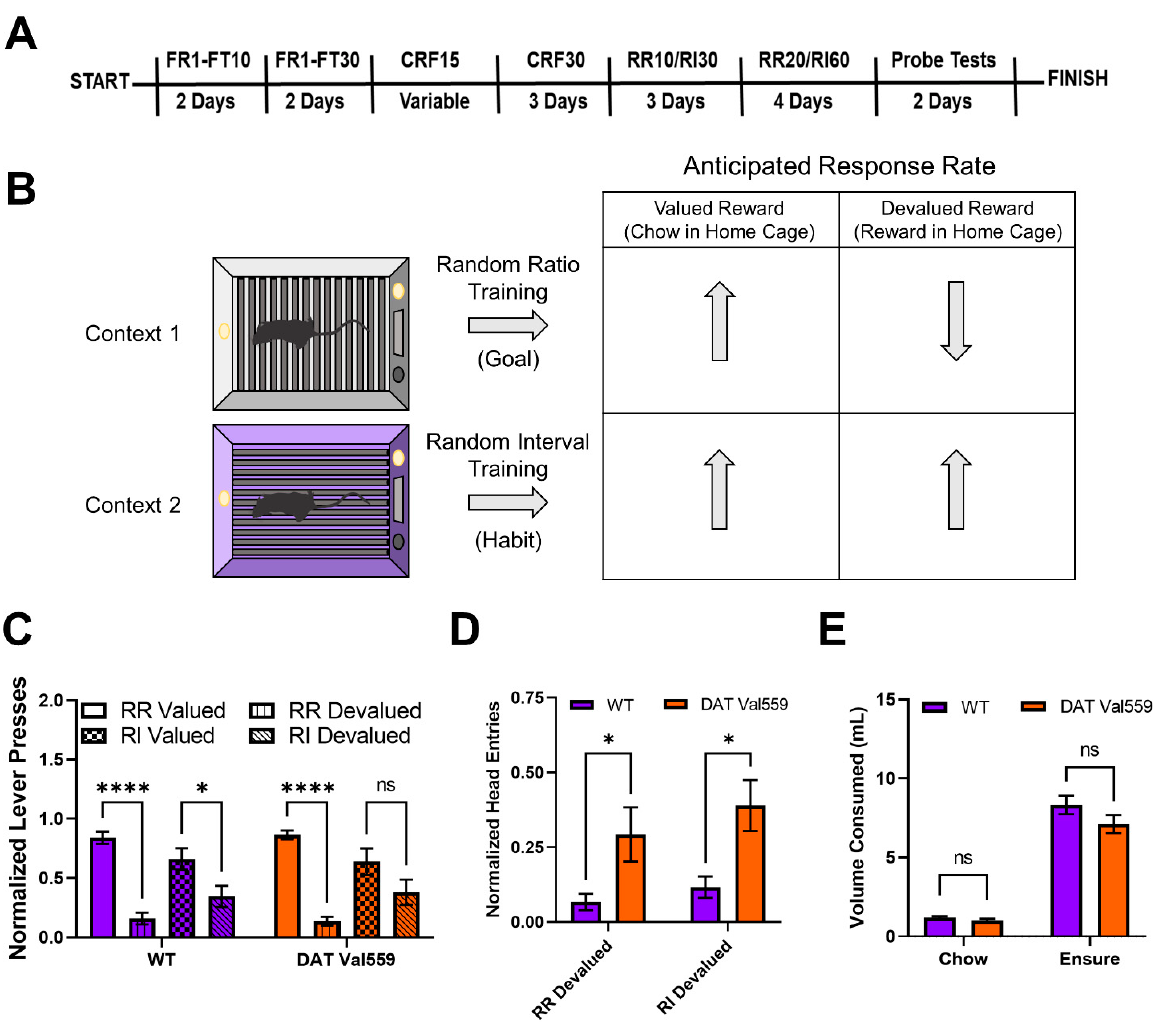
Figure 1. DAT Val559 males display compulsive reward seeking in devalued states for both goal- directed and habit driven behavioral contexts. WT ( n = 12) and DAT Val559 ( n = 10) males were subjected to a within subject lever pressing paradigm that utilizes contextual cues coupled to random ratio (RR) or random interval (RI) reinforcement schedules to bias animals toward goal-directed or habitual actions, respectively. ( A ) Overview of the training paradigm. ( B ) Representation of outcome expectations based on training schedule. ( C ) Normalized lever presses in the RR valued, RR devalued, RI valued, and RI devalued contexts. Two-way ANOVA revealed a significant impact of schedule/valuation (F(3, 80) = 32.32, p < 0.0001). ( D ) Normalized head entries into the reward delivery magazine. Two-way ANOVA revealed a significant effect of genotype (F(1, 37) = 14.82, p = 0.0005). ( E ) Reward (Ensure ® ) or chow consumption in the home cage prior to testing. No significant effects of genotype on reward or chow consumption were detected (F(1, 40) = 2.661, p = 0.1107). Data were analyzed by two-way ANOVA with Sidak’s multiple comparison’s test. * p < 0.05, **** p < 0.0001. ns = not significant. Data are presented as mean ± SEM.